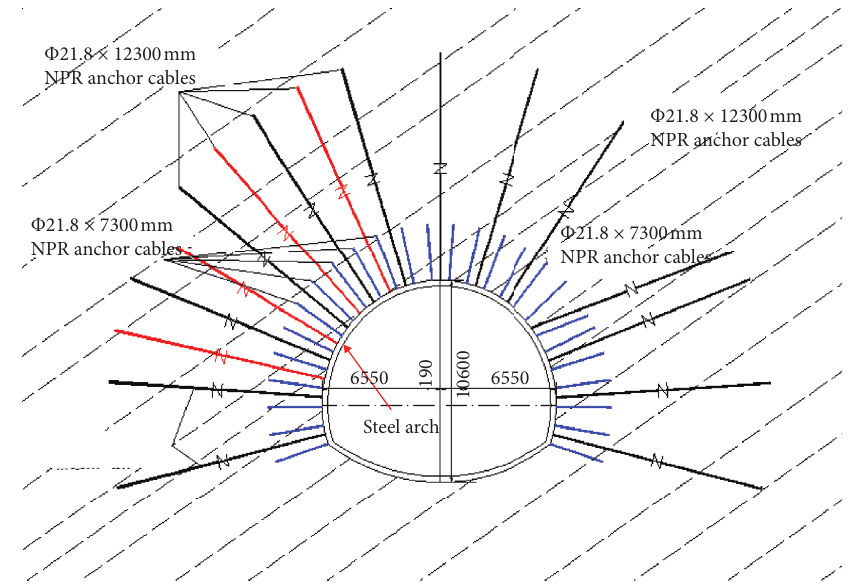
Figure 9: Schematic diagram of the support